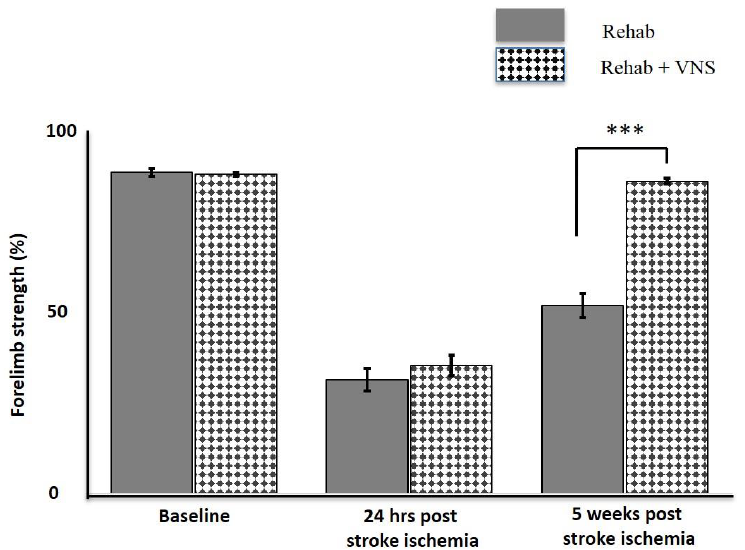
Figure 6. The average forelimb strength in the Rehab group (solid fill) and VNS along with Rehab group (pattern fill) over 5 weeks post stroke injury. The forelimb strength between groups were significantly different on the 5th weeks of VNS treatment and rehab n = 5. *** p < 0.001 [43 – 47].